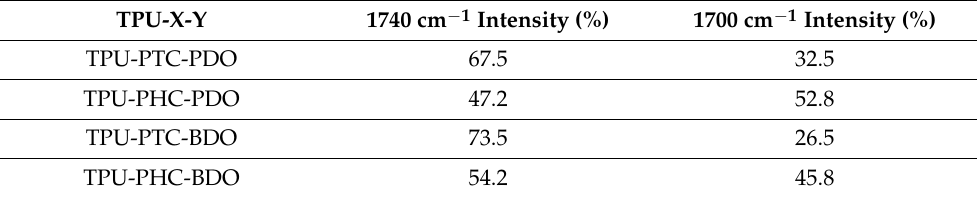
Figure 4. C=O characteristic deconvolution peaks of ( a ) TPU ‐ PTC ‐ PDO, ( b ) TPU ‐ PHC ‐ PDO, ( c ) TPU ‐ PTC ‐ BDO, and ( d ) TPU ‐ PHC ‐ BDO. Table 2. Ratios of the intensities of the IR bands at 1740 and 1700 cm − 1 in the ATR ‐ IR spectra of the polycarbonate TPUs.